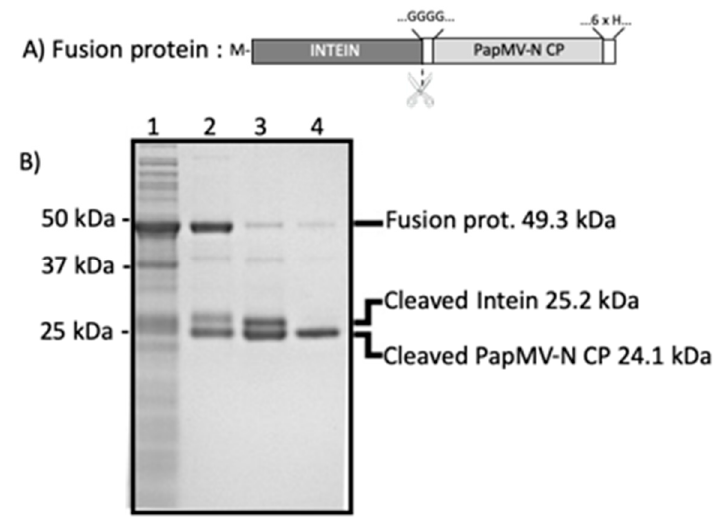
Figure 1. Purification of papaya mosaic virus with peptide at the N-terminus (PapMV-N) coat protein (CP). ( A ) Schematic representation of the intein–PapMV-N CP construct cloned in the pTWIN1 vector and expressed in Escherichia coli . The N-terminal methionine of the fusion protein is shown with a M. The site of cleavage by the intein is illustrated with scissors. Upon cleavage, the N-terminus of the PapMV-N CP presents GGGG at its N-terminus. The PapMV-N CP harbors a 6His-tag at its C-terminus to ease the purification process. ( B ) SDS-PAGE revealing the protein content of samples taken at successive purification steps of the PapMV-N CP. Molecular weight markers are shown to the left. Signals corresponding to the fusion protein (49.3 kDa), the cleaved intein (25.2 kDa), and the cleaved PapMV-N CP (24.1 kDa) are indicated on the right. Lanes: 1 lysate of induced bacteria